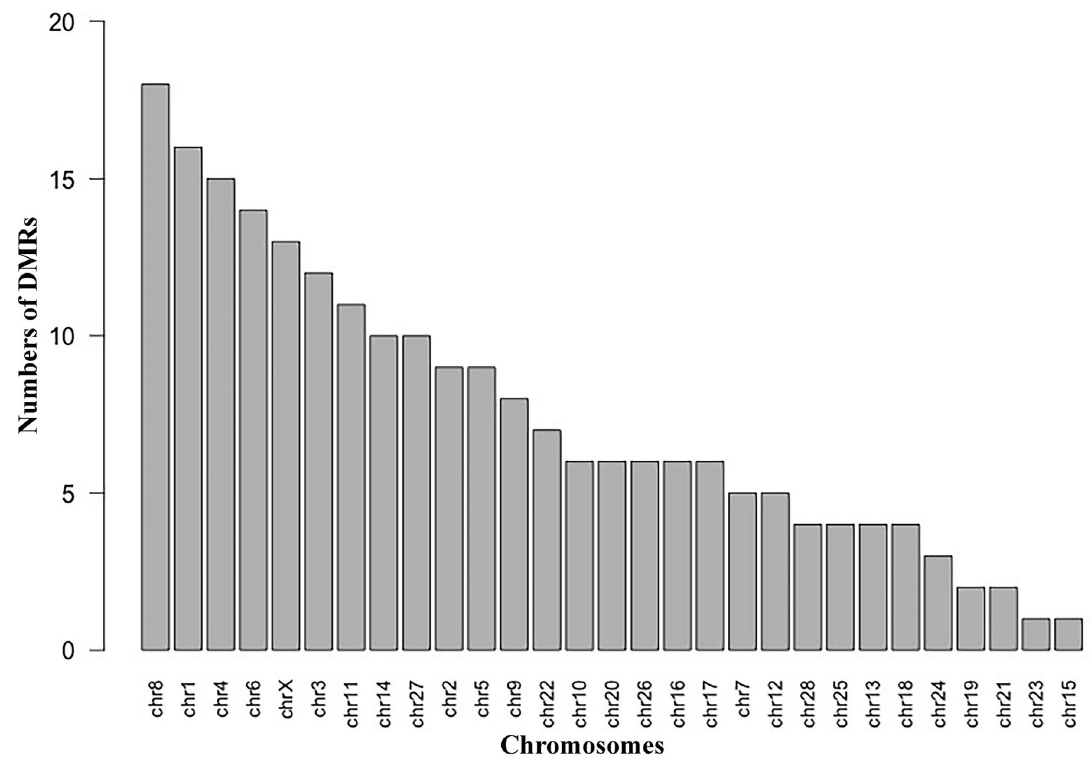
Fig 4. Chromosomal location frequencies of the DMRs. Distribution of the DMRs per chromosome without normalization (ignoring chromosome